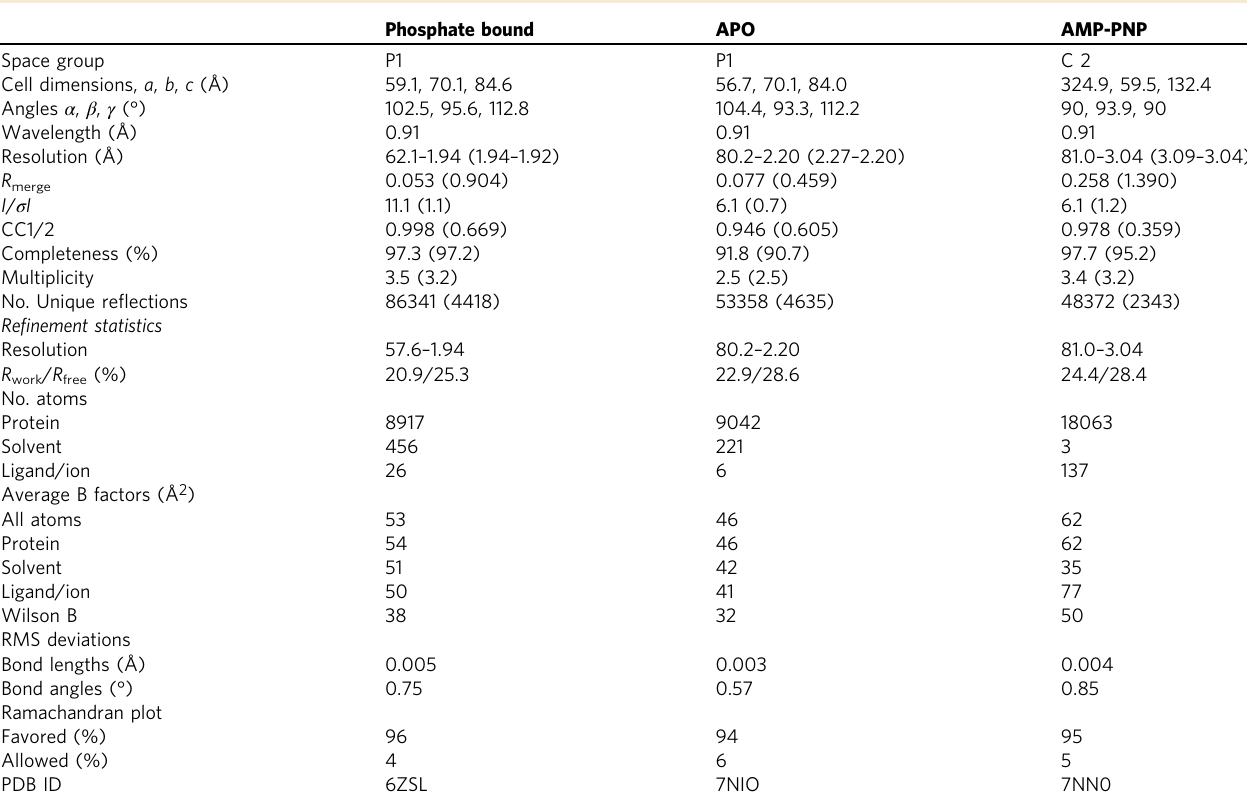
Table 1 Data collection and re fi nement